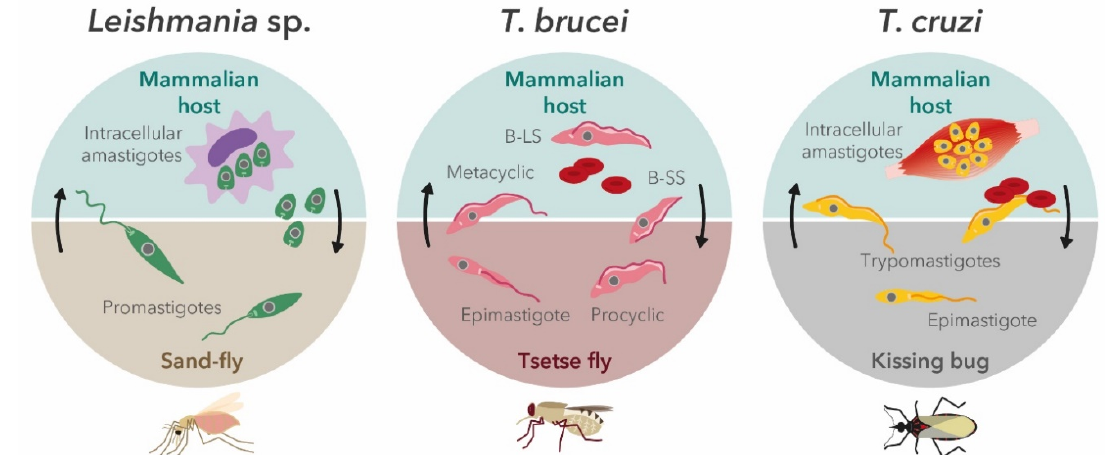
Figure 2. Life cycles of pathogenic trypanosomatid parasites. The clinically relevant life-cycle stages that are targets for drug intervention are intracellular amastigotes in Leishmania sp.; bloodstream forms (bloodstream long slender form (B-LS) and bloodstream short stumpy form (B-SS)) in Trypanosoma brucei ; and infective trypomastigotes and intracellular amastigotes in Trypanosoma cruzi